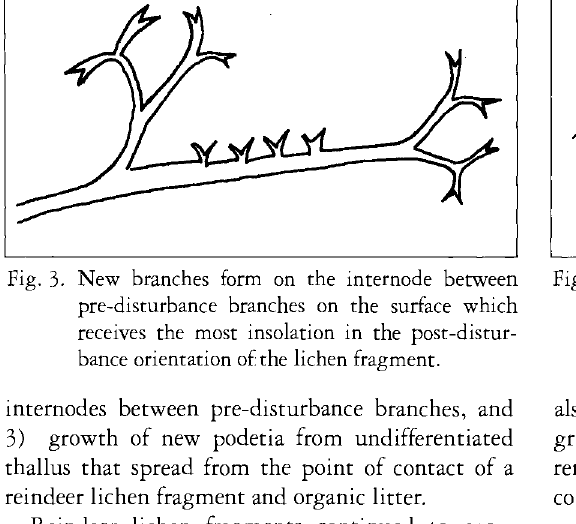
Fig. 4. Undifferentiated thallus spreads from rhe points of contact of the reindeer lichen fragment and the organic substrate. New podetia form from the undifferenriared